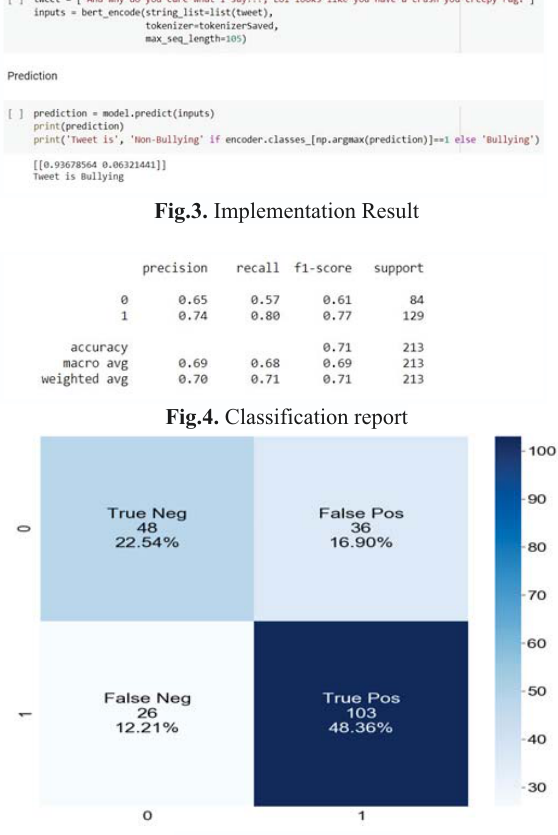
Fig. 5. Confusion